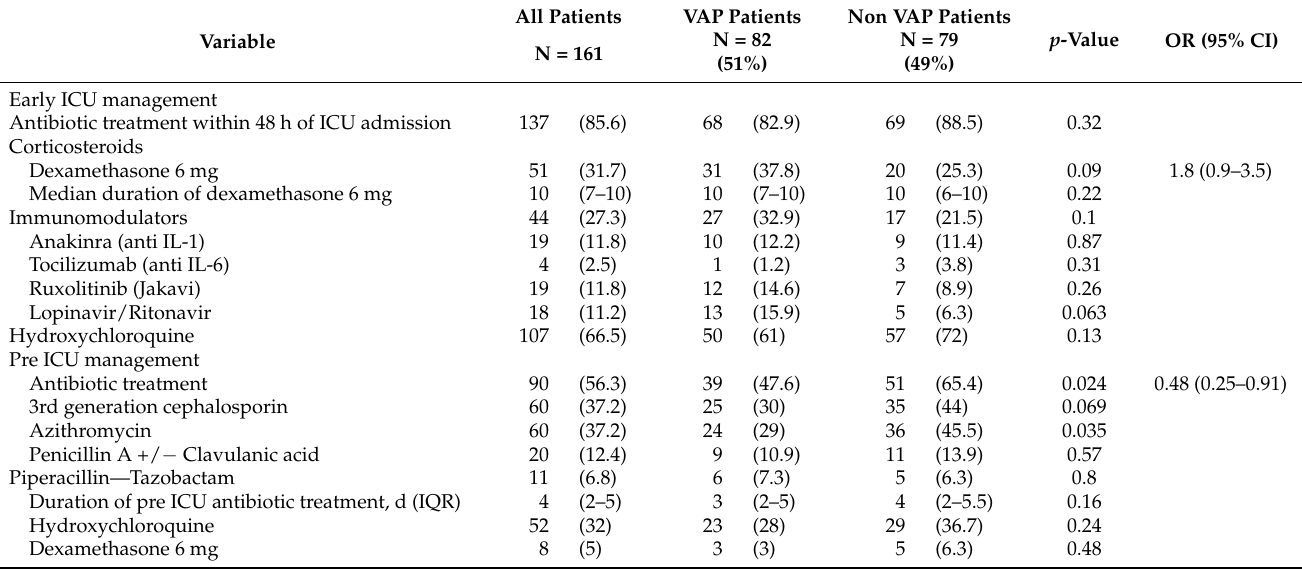
Table 2. Anti-infective